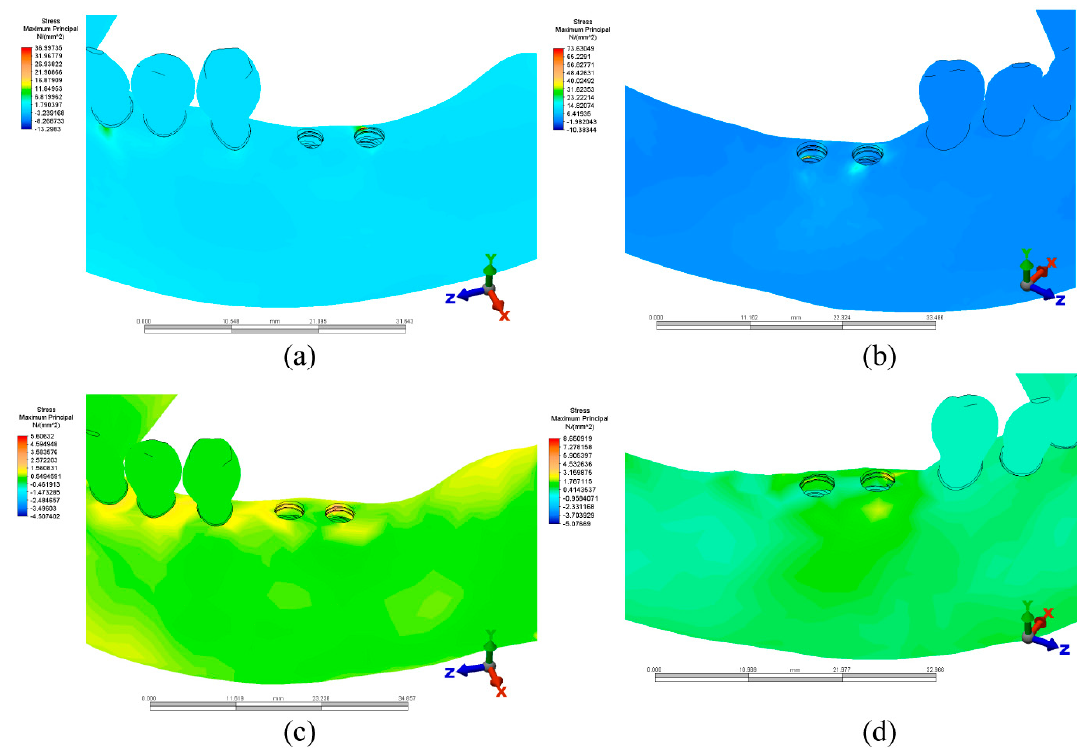
Figure 5. Maximum principal stress values and distribution in mandibular bone in the resorbed model for the third ( a ) and fourth ( b ) quadrant and the virtually bone augmented model for the third ( c ) and fourth ( d ) quadrant.